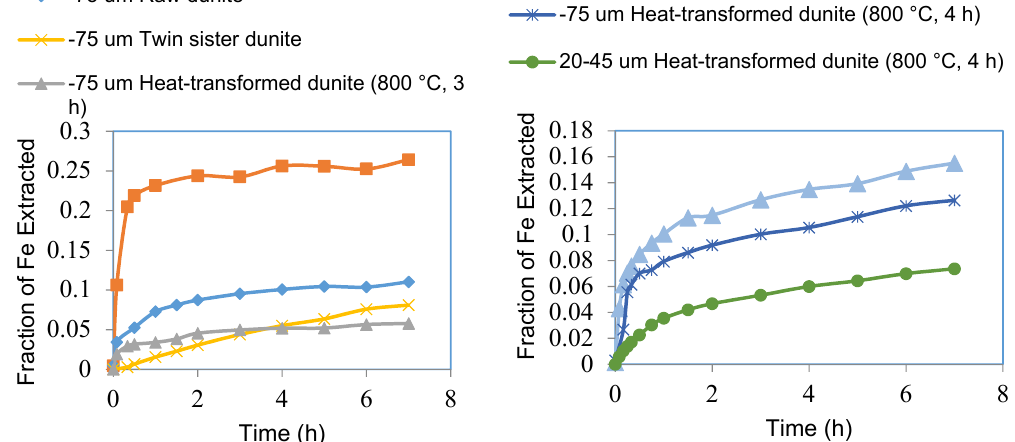
Figure 9. Fraction of iron extracted from sub-75 µm fractions of raw dunite, heat-activated dunite (630 °C, 4 h), heat-transformed dunite (800 °C, 3 h), and twin sister dunite (left). Fraction of magnesium extracted from sub-75 µm fraction, sub-20 µm fraction, and 20–45 µm fraction of heat-transformed dunite (800 °C, 4 h) (right).